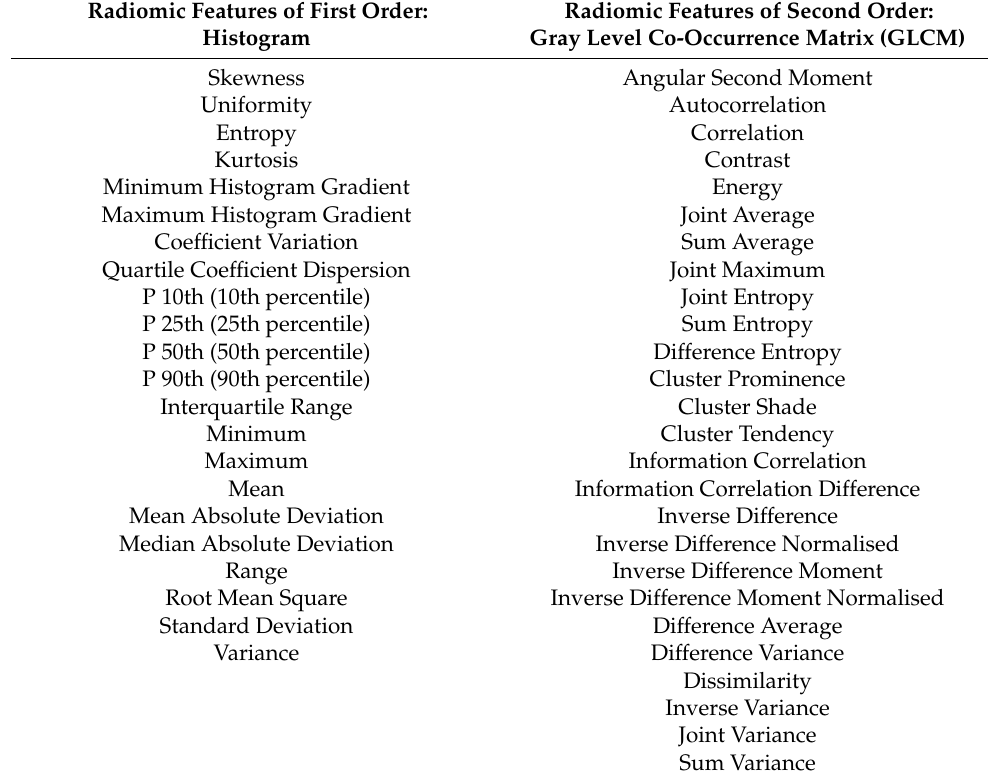
Table A2. Radiomic features used for model